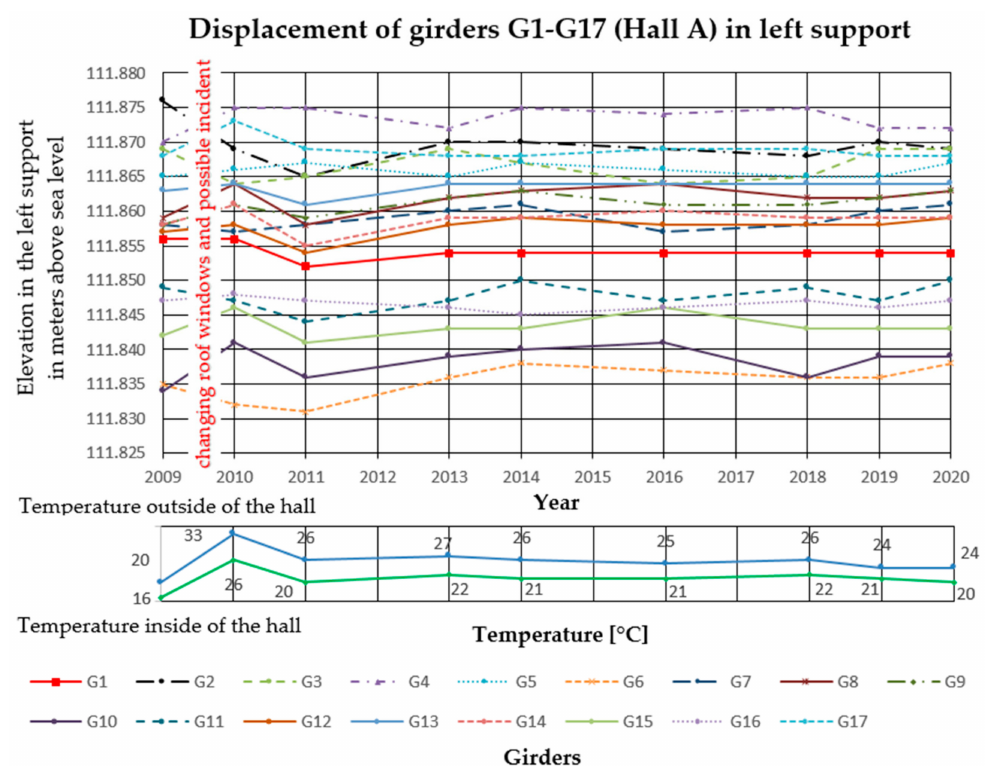
Figure 8. Displacement of the left site of the girders in Hall